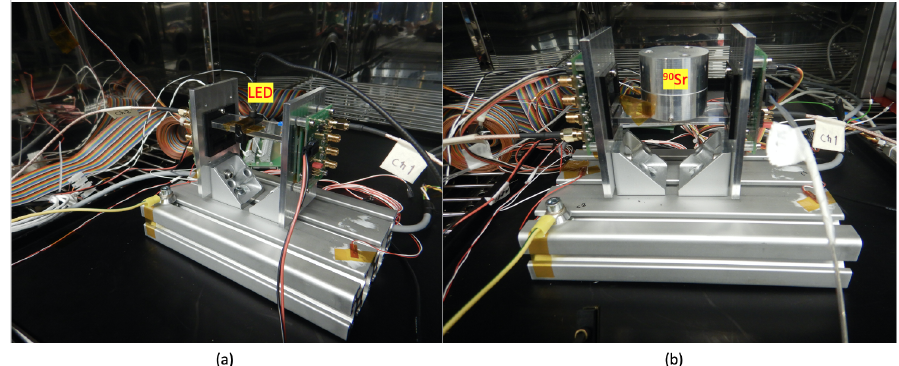
Figure 4. The TOF prototype test setup: ( a ) A LED (375 nm) injects the light into the scintillator for systematic study; ( b ) on top of the scintillator surface, a radioactive source ( 90 Sr) is employed to investigate the performance of the prototype.